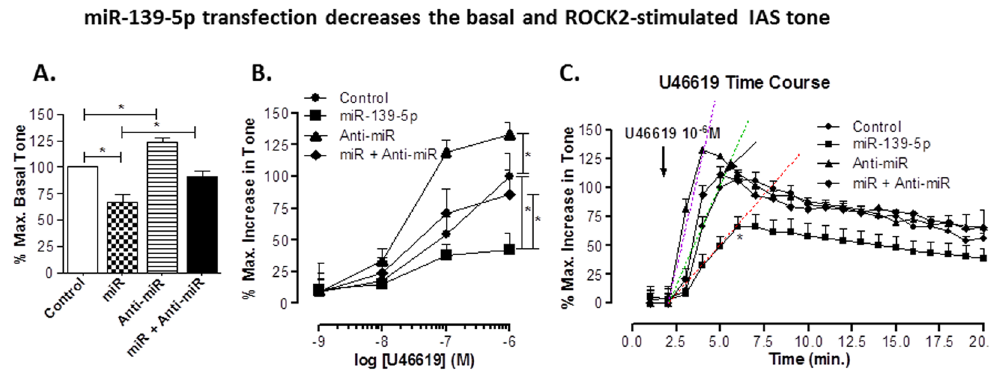
Figure 5. Effect of miRNA- and anti-miRNA-139-5p. ( A ) miRNA-139-5p (100 nM) produces significant ( * p < 0.05; n = 5) decrease in the IAS tone, as compared with scrambled miRNA (control), which is significantly blocked by pre-treatment with 100 nM antagomir ( * p < 0.05; n = 5). Conversely, 100 nM antagomir by itself significantly ( * p < 0.05; n = 4) increases the IAS tone as compared to control. ( B) miRNA-139-5p significantly shifts U46619 CRC causing an increase in the IAS tone towards right ( * p < 0.05; n = 6–8), which is attenuated by the antagomir. In contrast, the antagomir causes a significant shift in the control CRC to left ( p > 0.05;